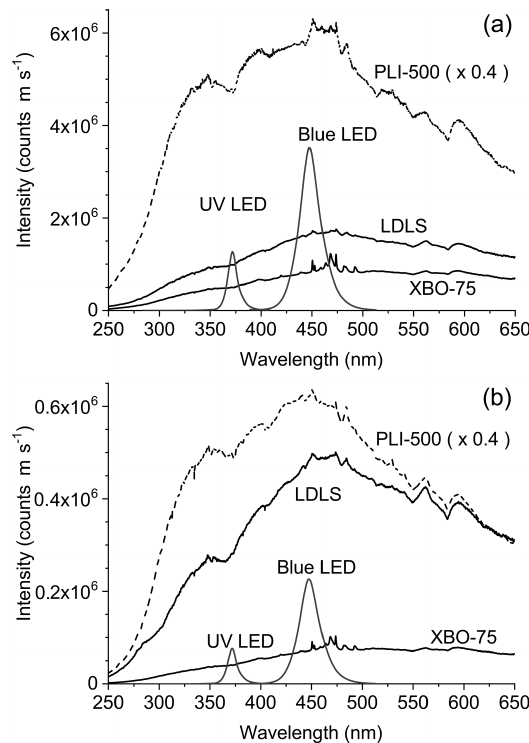
Figure 3. Intensities of several light sources measured on the short- cut plate (no atmospheric light path). The position of the lens fo- cussing the light sources onto the fibre was adapted to the respective spectral region. (a) Light coupled into a bundle in classical configu- ration (see Fig. 2) with 800µm fibre diameter. (b) Light coupled into the same bundle with an additional 200µm fibre added in front of the 800µm fibre of the bundle (also in classical configuration; see Fig. 2). For better comparison, the PLI_500 has been downscaled. Please note that for comparisons between both setups and panels the loss by the additional coupling of the 200µm fibre, which we estimate to be around 20%–25%, has to be taken into